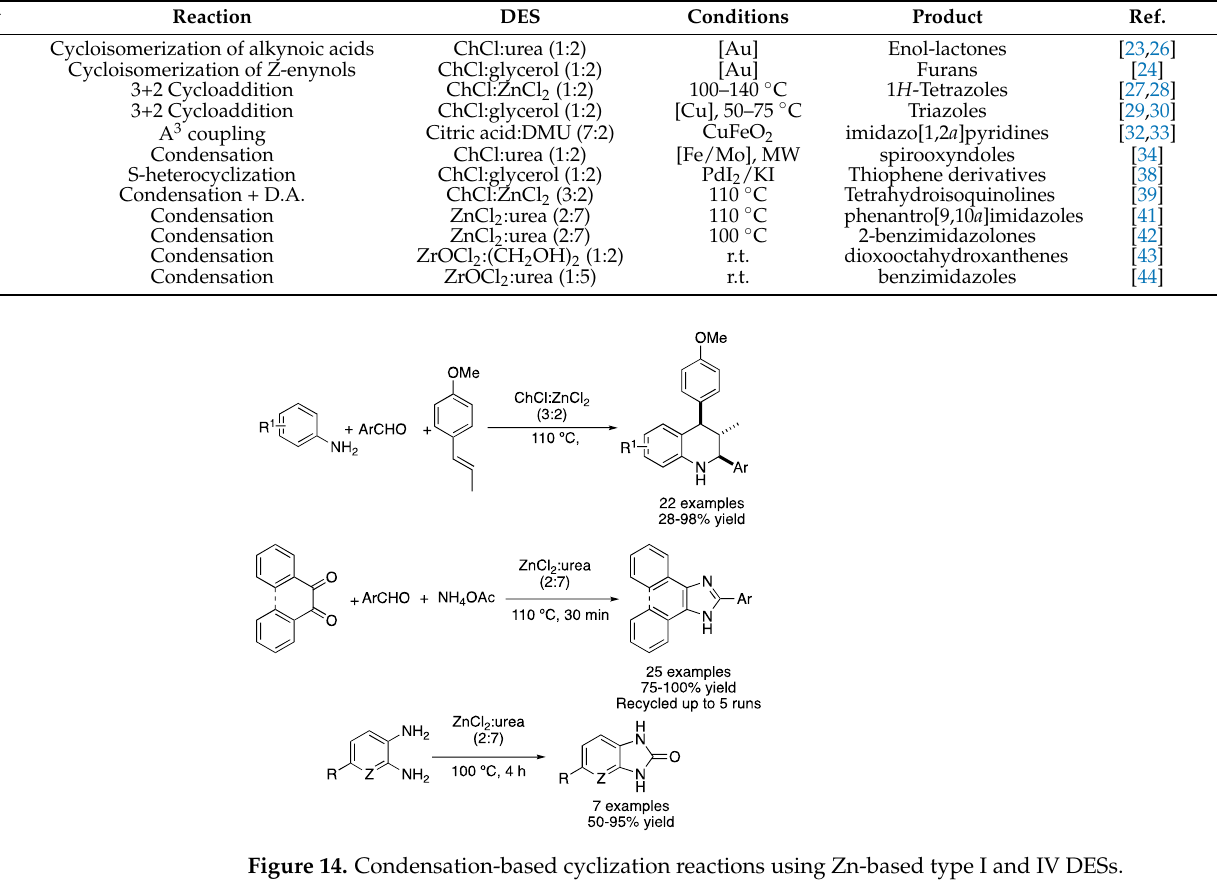
Table 2. Selected examples of cyclization processes catalyzed by transition metals in DESs.